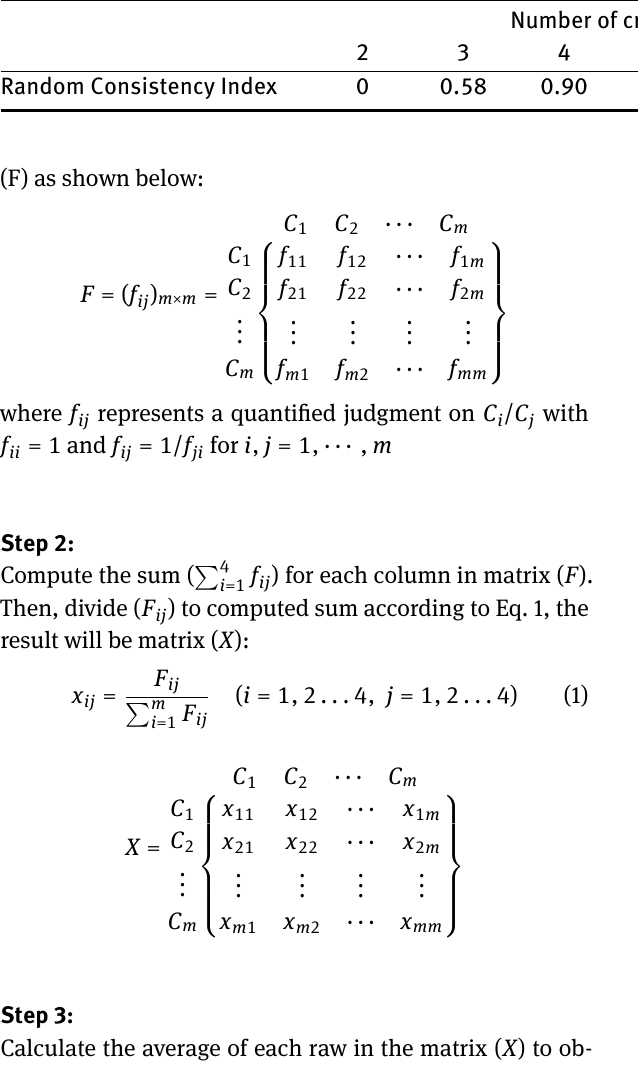
Table 8: Values of the Random Consistency Index (RCI) for small problems.